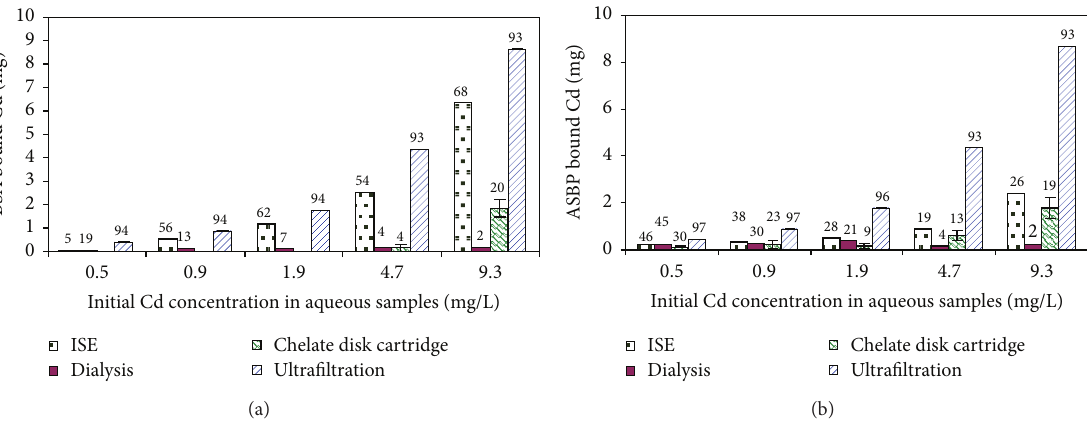
Figure 2: Comparison of biopolymer-bound cadmium using four different analytical techniques (ISE, dialysis, chelate disk cartridge and ultrafiltration), in 1L solution (a) BSA; (b) ASBP. The values on the columns represent the percentage of biopolymer-bound cadmium to total added cadmium before adsorption test. Error bars represent observed low and high values for duplicate experiments.